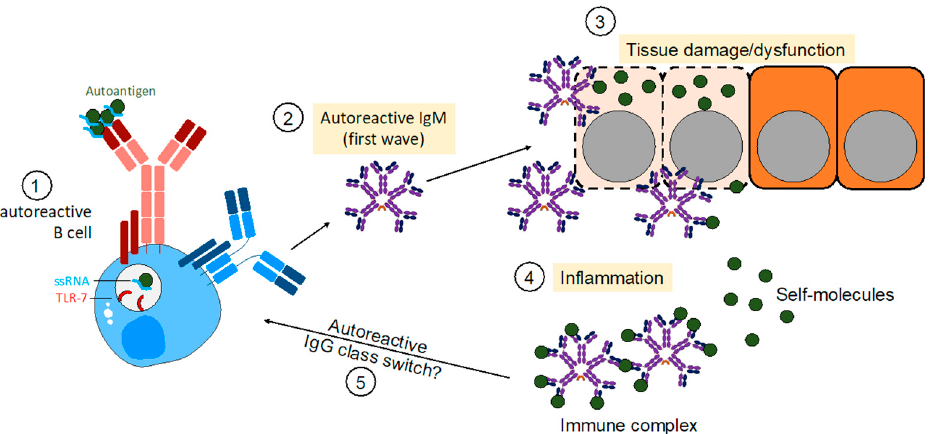
Figure 2. Autoreactive IgM in establishing autoimmunity. Model of how initial TLR7 signals induce autoreactive B cell activation of self-reactive B cells. In a subsequent first wave, autoreactive B cells produce IgM autoantibodies binding to self-antigens thereby inducing neutralization of targets or tissue damage. Consequently, tissue damage establishes an inflammatory environment leading to the activation of further self ‐ reactive B cells. In the end, autoreactive IgM is capable of causing autoimmune diseases without the presence of IgG autoantibodies.